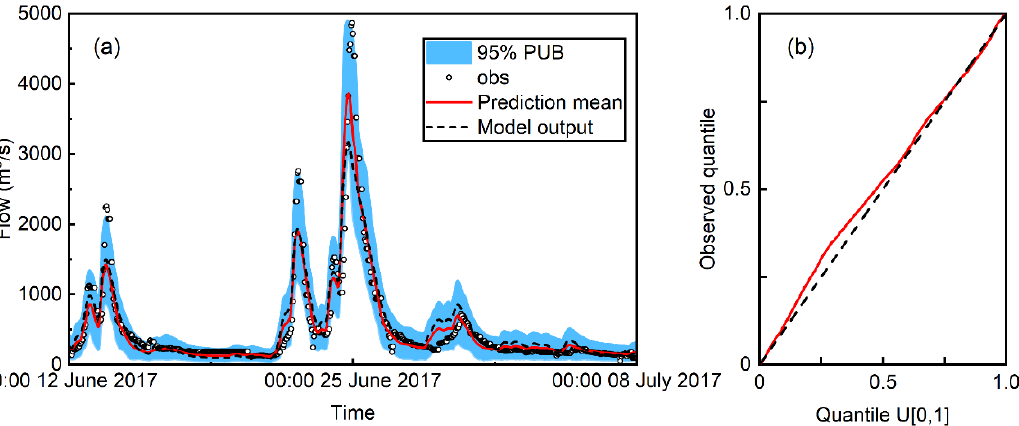
Figure 10. Typical examples of probabilistic streamflow predictions in the Changshangang River Basin for the ‘KF’ scenario: ( a ) mean and the 95% PUBs for the flood prediction with deterministic model output and flood observations; ( b ) PQQ plot for all simulated flood events.